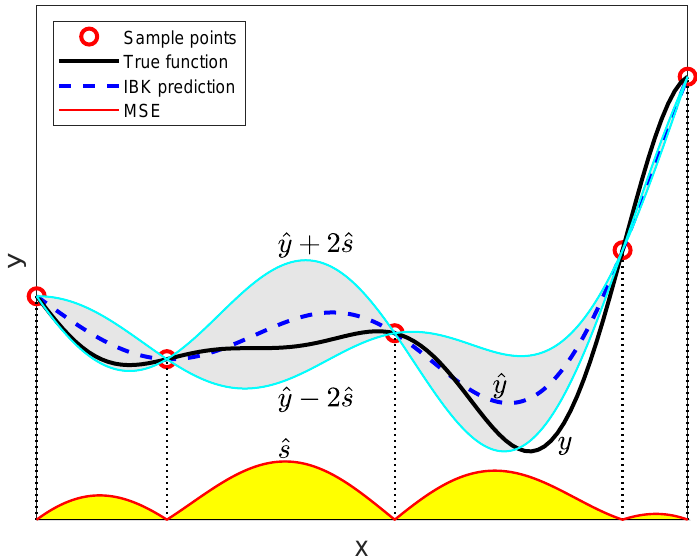
Figure 1. Mean square error of the IBK